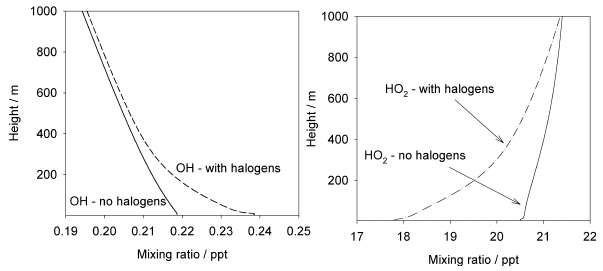
Fig. 6. Vertical profiles of modelled OH and modelled HO 2 at Cape Verde for two scenarios: with and without halogen chemistry. At the height of the measurements, the model scenario without halo- gen chemistry over-predicts HO 2 by ∼ 14% of the measured mix- ing ratio, and under-predicts the OH by ∼ 13%. Average observed OH = 0.25pmolmol − 1 and HO 2 = 18pmolmol − 1 (Whalley et al., 2009).